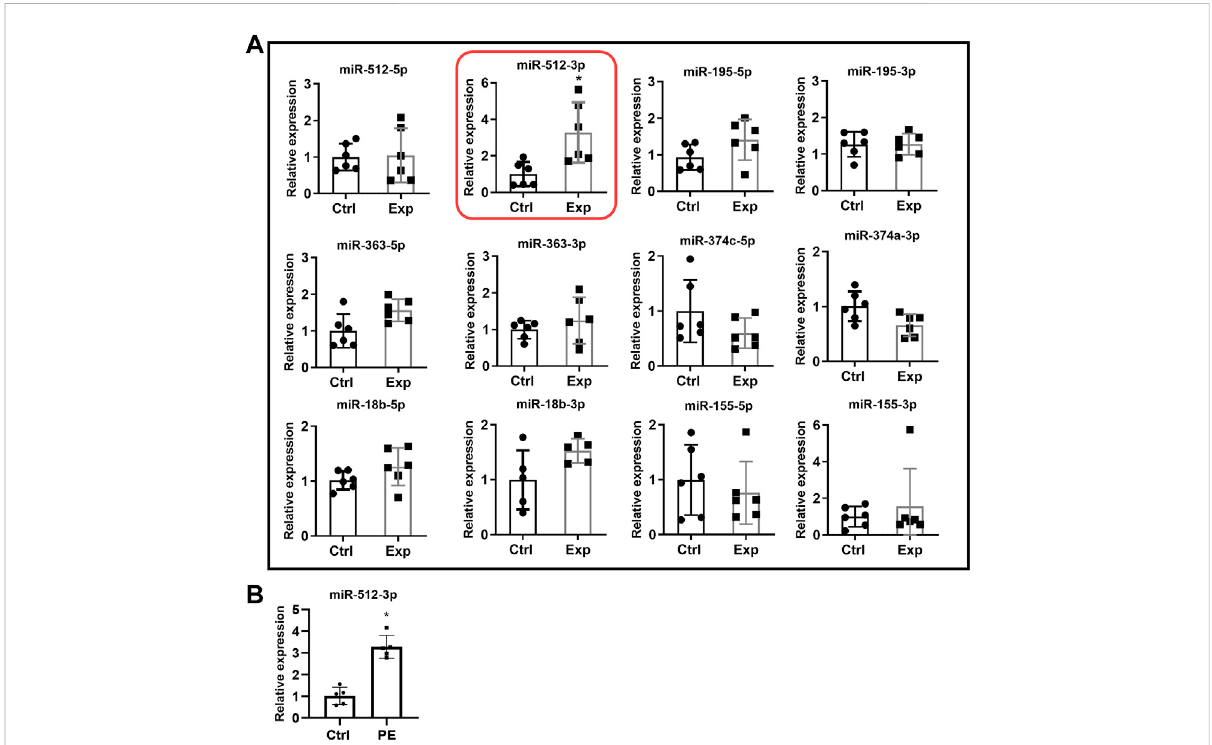
FIGURE 1 (A) MiRNA expression in HTR-8/SVneo cells in the presence or absence of exogenous DCN. HTR-8/SVneo cells were exposed to vehicle (Ctrl) or250 nMDCN(Exp)for24 h,andthenqRT-PCRwasusedtomeasureexpressionofselectmiRNAs.OnlymiR-512-3pwassigni fi cantlyupregulated. Ctrl: cells not exposed to DCN. Exp: cells exposed to DCN. Time frame used for experiment: 24 h (N = 4 – 6, * p < 0.05). (B) Increased expression of miR-512-3p in PE placentas. Relative expression of miR-512-3p based on qRT-PCR analyses of placenta tissue samples derived from healthy normotensive control (Ctrl) and preeclamptic (PE) pregnancies. Analysis performed using Student ’ s t-test. Error bars extending to ± SEM. (* p ≤ 0.05, n = 5 biological